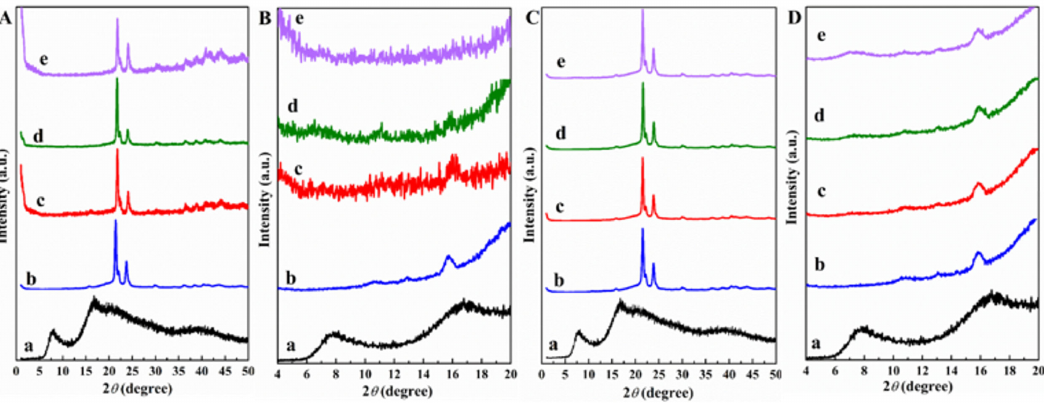
Figure 3. XRD patterns ( A , B ) solution blended, ( C , D ) melt mixed: ( a ) APIOPOSS, ( b ) PCL, ( c ) PCL/APIOPOSS-2, ( d ) PCL/APIOPOSS-5, ( e ) PCL/APIOPOSS-10; ( B , D ): enlarged XRD patterns in the 2 θ range 5–20 degrees.